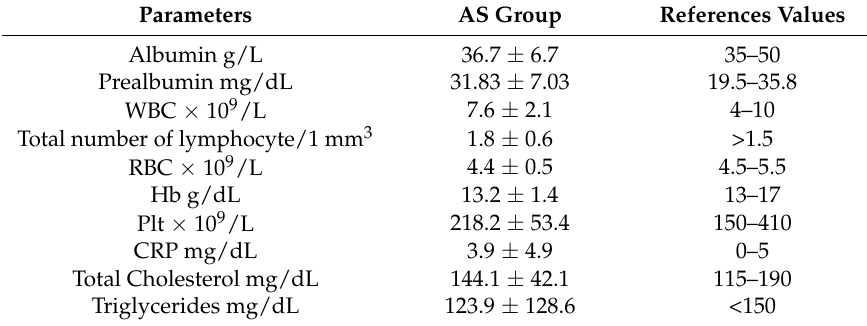
Table 3. Biochemical parameters in the AS